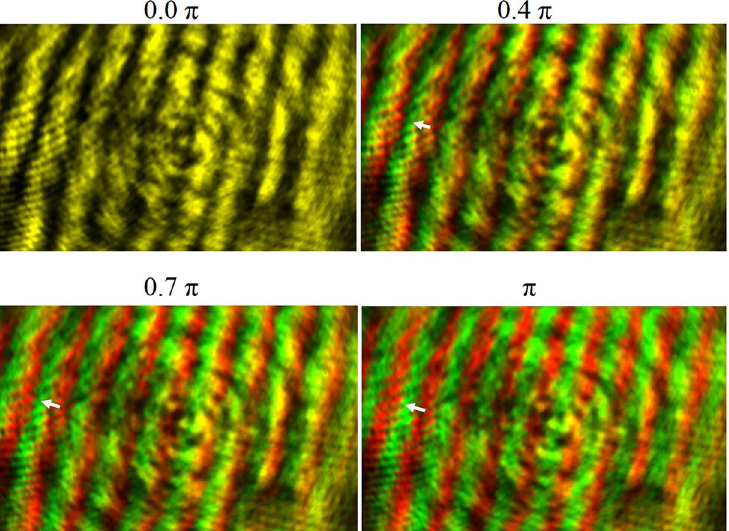
Figure 4. Images of fringe pattern recorded on CMOS. The fringe patterns are for different values of phase shift. The first pattern is when there is no change in phase. For the case of a finite phase shift, the shifted and the initial fringe pattern are indicated by green and red color (false color) respectively. The small white color arrow shows the direction of shift.